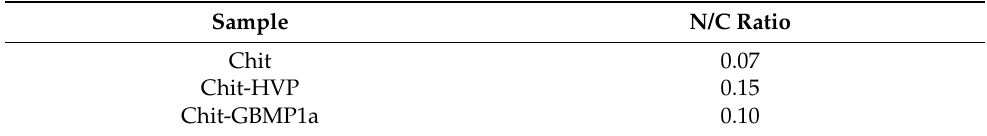
Table 2. N/C ratio measured for Chit, Chit-HVP and Chit-GBMP1a.